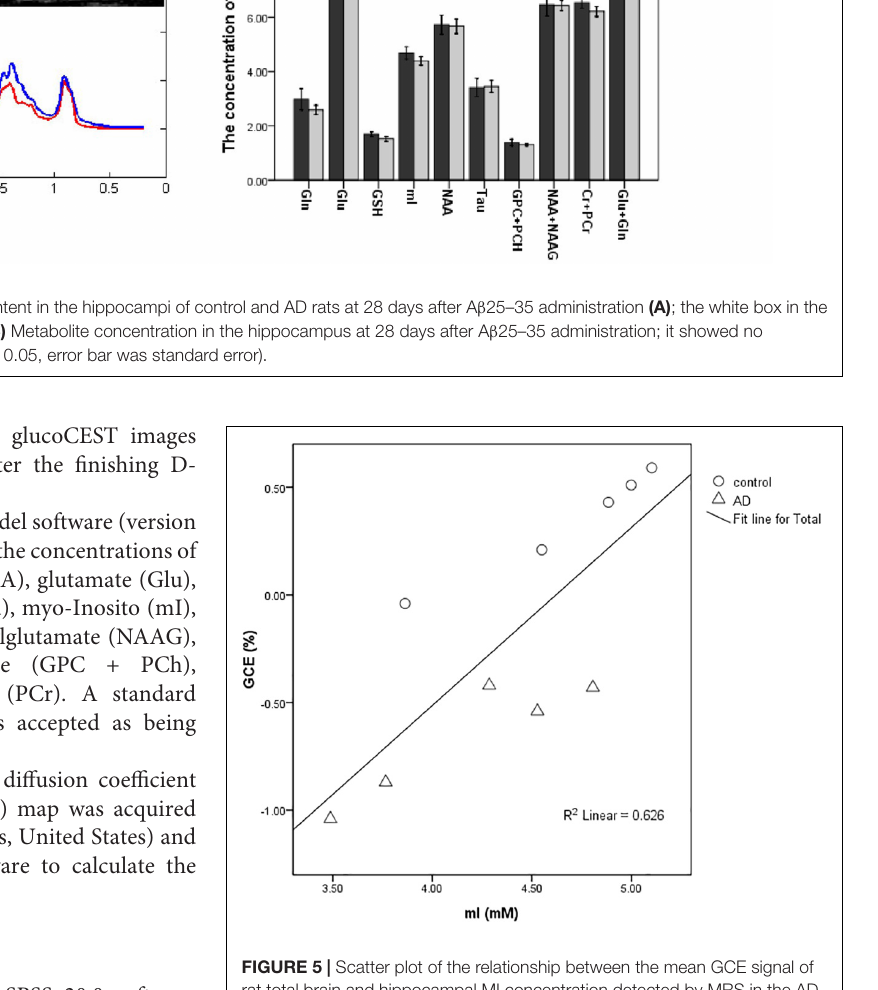
( Figure 1A ). The overlap of CEST effects of different metabolites is more serious with the increased saturation power from 1.5 to 6 µ T ( Figures 1B,C